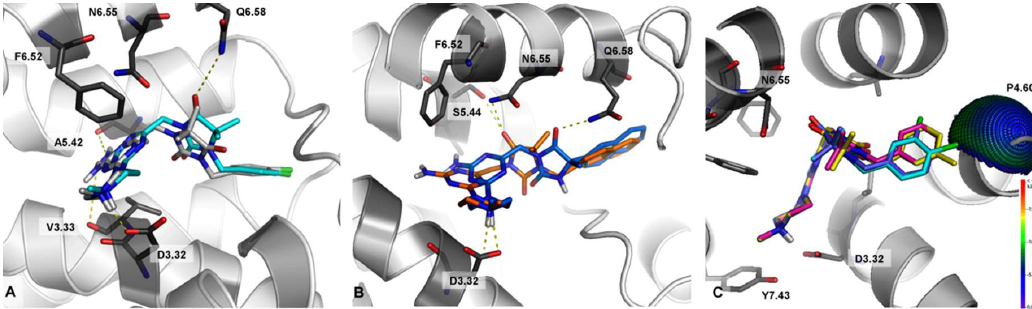
Figure 8. Molecular docking results of the representative library members for the 5-HT 6 receptor. ( A ) Comparison of the binding mode of compounds 6 (cyan) and 7 (gray). ( B ) Binding mode of 18 (orange) and 26 (blue). ( C ) A superposition of the poses of compounds 9 (magenta), 17 (yellow), 6 (cyan), and 10 (violet) against the putative halogen binding pocket interaction spheres for the 5-HT 6 receptor. The chlorine-oxygen theoretical interaction spheres illustrate the projected qualities of the formed ligand-receptor halogen bonds. Key residues in the binding site are presented as thick dark-grey sticks. The dotted yellow lines represent hydrogen bonds with polar residues.